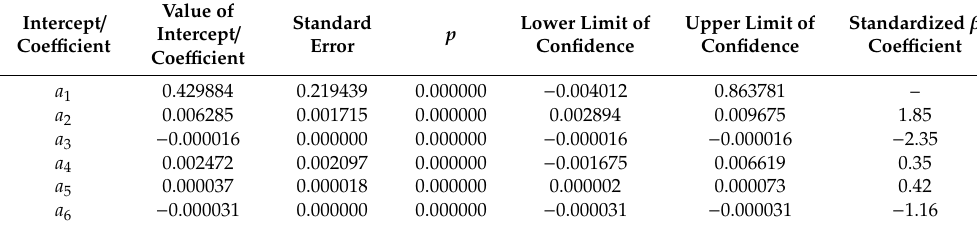
Figure 4. Visualization of 3D model of energy yield ( EY ) of pruned biomass torrefaction. Table 2. Statistical evaluation of energy yield ( EY ) model of pruned biomass torrefaction.